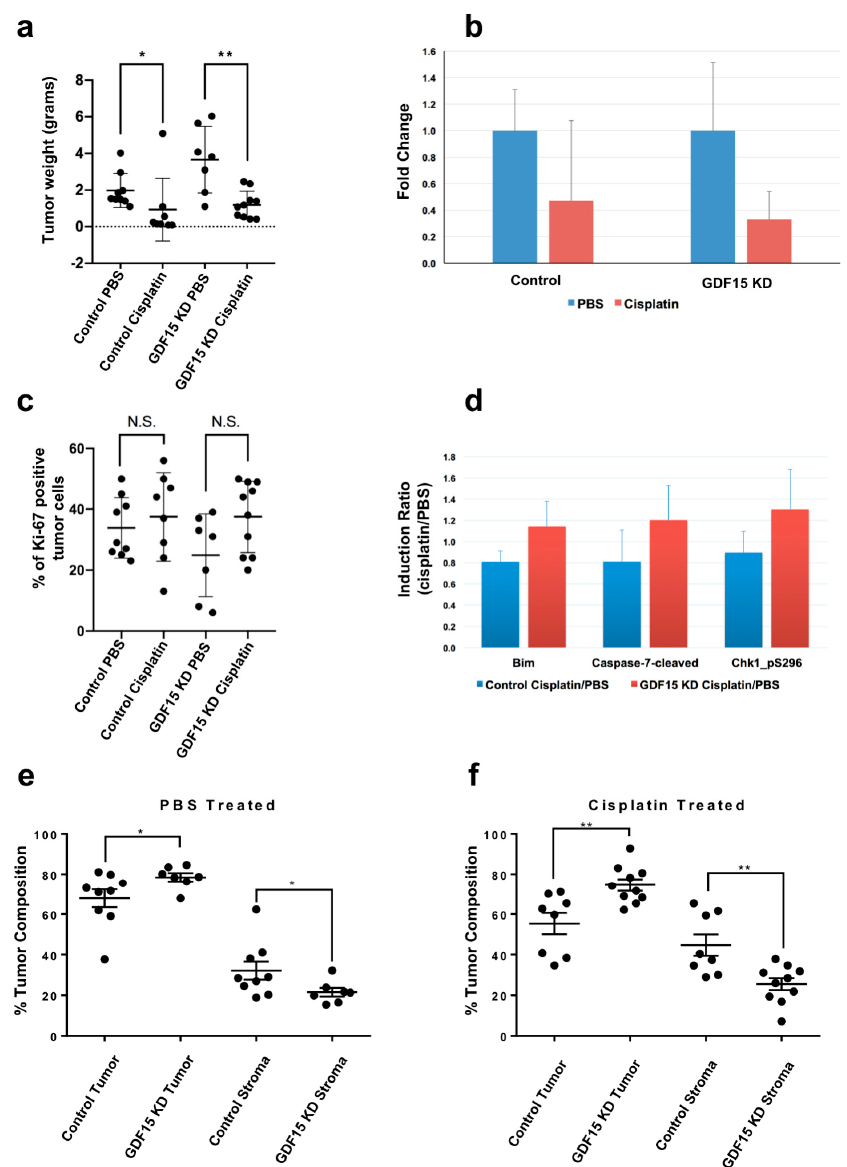
Figure 5. The impact of GDF15 KD on ovarian tumor growth, cisplatin response and tumor composition; ( a ) Tumor weights in mice after treatment with PBS or cisplatin. * p = 0.0079; ** p = 0.0046; ( b ) Fold decrease in tumor weights after treatment with cisplatin normalized to control tumors treated with PBS; ( c ) Percentage of Ki67-positive ovarian tumor cells in the tumor. N.S., not significant; ( d ) RPPA analysis results showing induction of higher expression of the apoptotic proteins Bim, cleaved caspase-7, and phosphorylated Chk1 after treatment with cisplatin in GDF15-KD A2780 tumors compared to normal A2780 tumors; ( e ) Percentage of tumor and stromal cells in mouse A2780 and GDF15-KD A2780 tumors after treatment with PBS; ( f ) Percentage of tumor and stromal cells in mouse A2780 and GDF15-KD A2780 tumors after treatment with